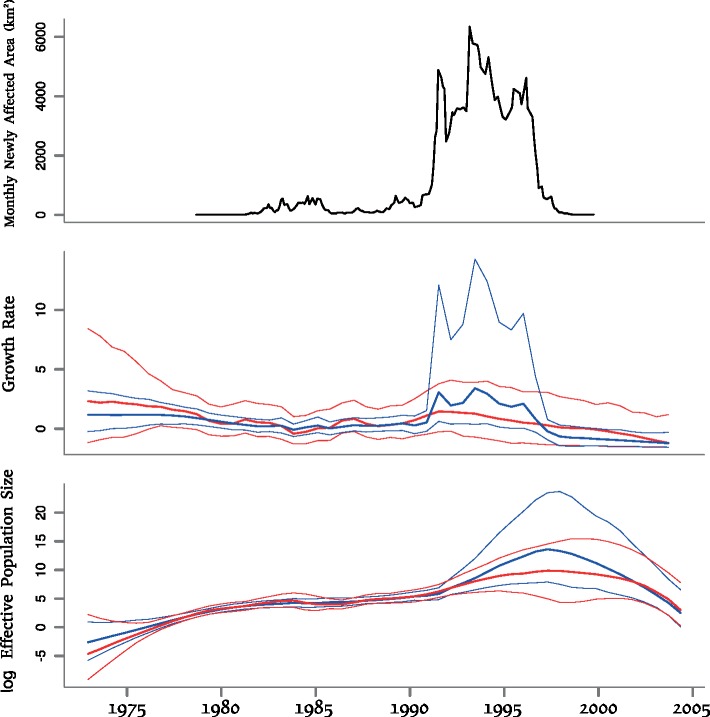
Results on the rabies application. Top: covariate data, representing the area in km\documentclass[12pt]{minimal}
\usepackage{amsmath}
\usepackage{wasysym}
\usepackage{amsfonts}
\usepackage{amssymb}
\usepackage{amsbsy}
\usepackage{upgreek}
\usepackage{mathrsfs}
\setlength{\oddsidemargin}{-69pt}
\begin{document}
}{}$^2$\end{document} newly affected by rabies recorded monthly between September 1978 and October 1999. Middle: growth rate estimates. Bottom: log effective population size estimates. The middle and bottom plots show results without (red) and with (blue) the use of the covariate data, and with a solid line indicating posterior means and shaded areas indicating the 95% credible regions.